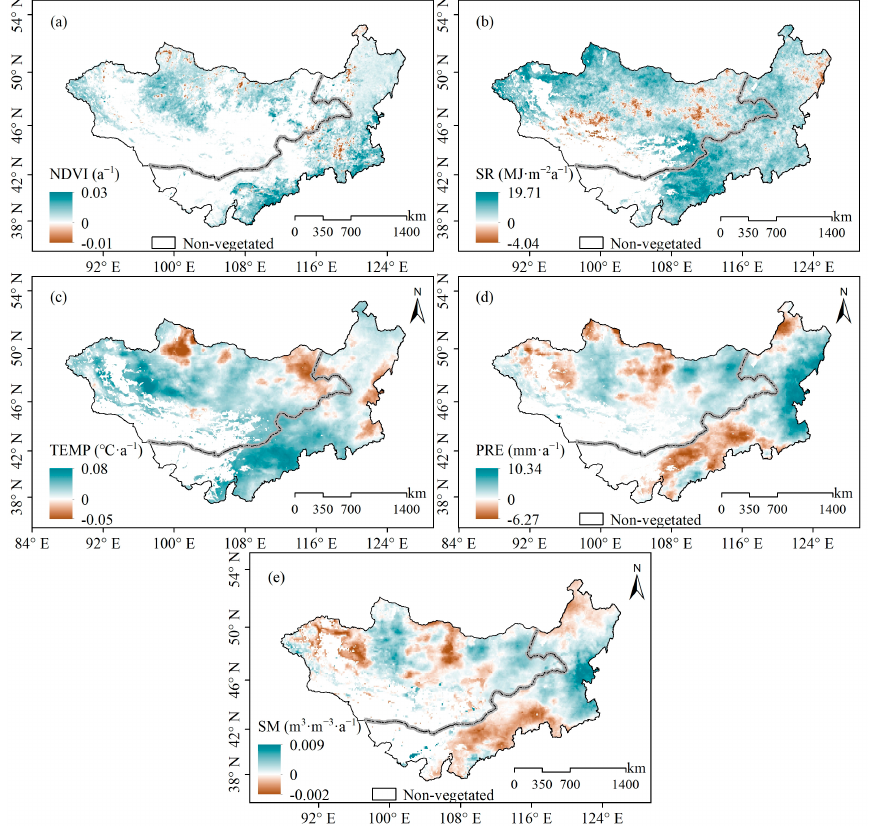
Figure 9. Spatial variations of NDVI ( a ); SR ( b ); TEMP ( c ); PRE ( d ); and SM ( e ) during the growing seasons from 2000 to 2019 in the MP.